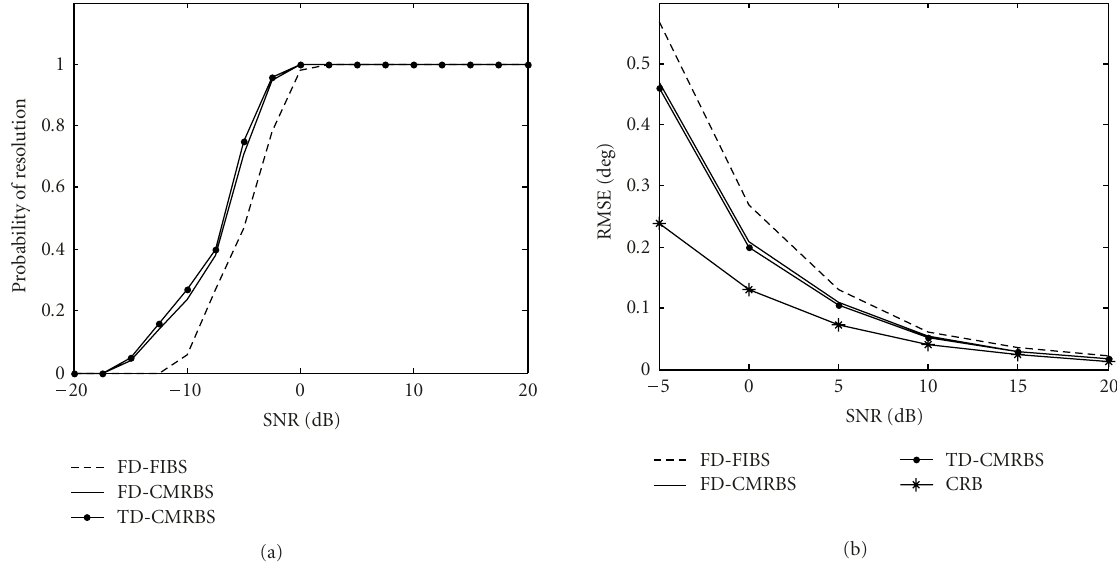
Figure 5: Performance comparison of FD-FIBS, FD-CMRBS, and FD-CMRBS for several SNR values. (a) Comparison of the resolution performance. (b) Comparison of the